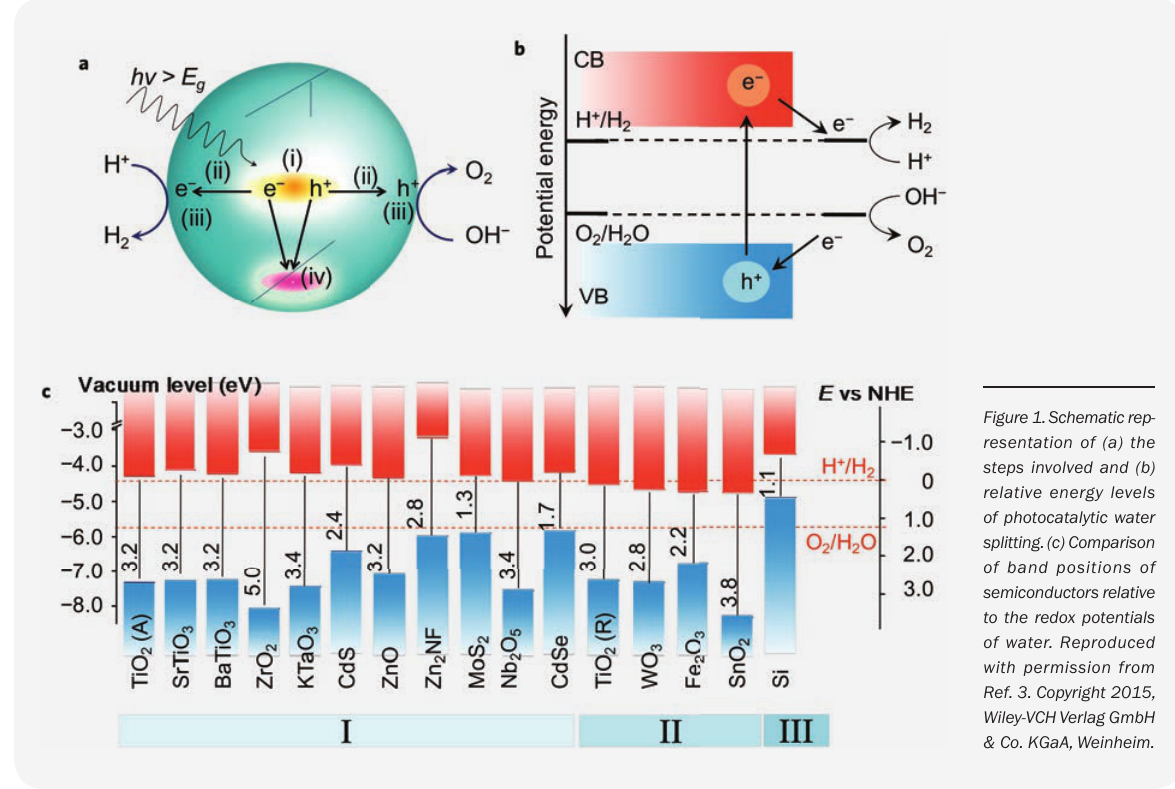
Figure 1. Schematic rep- resentation of (a) the steps involved and (b) relative energy levels of photocatalytic water splitting. (c) Comparison of band positions of semiconductors relative to the redox potentials of water. Reproduced with permission